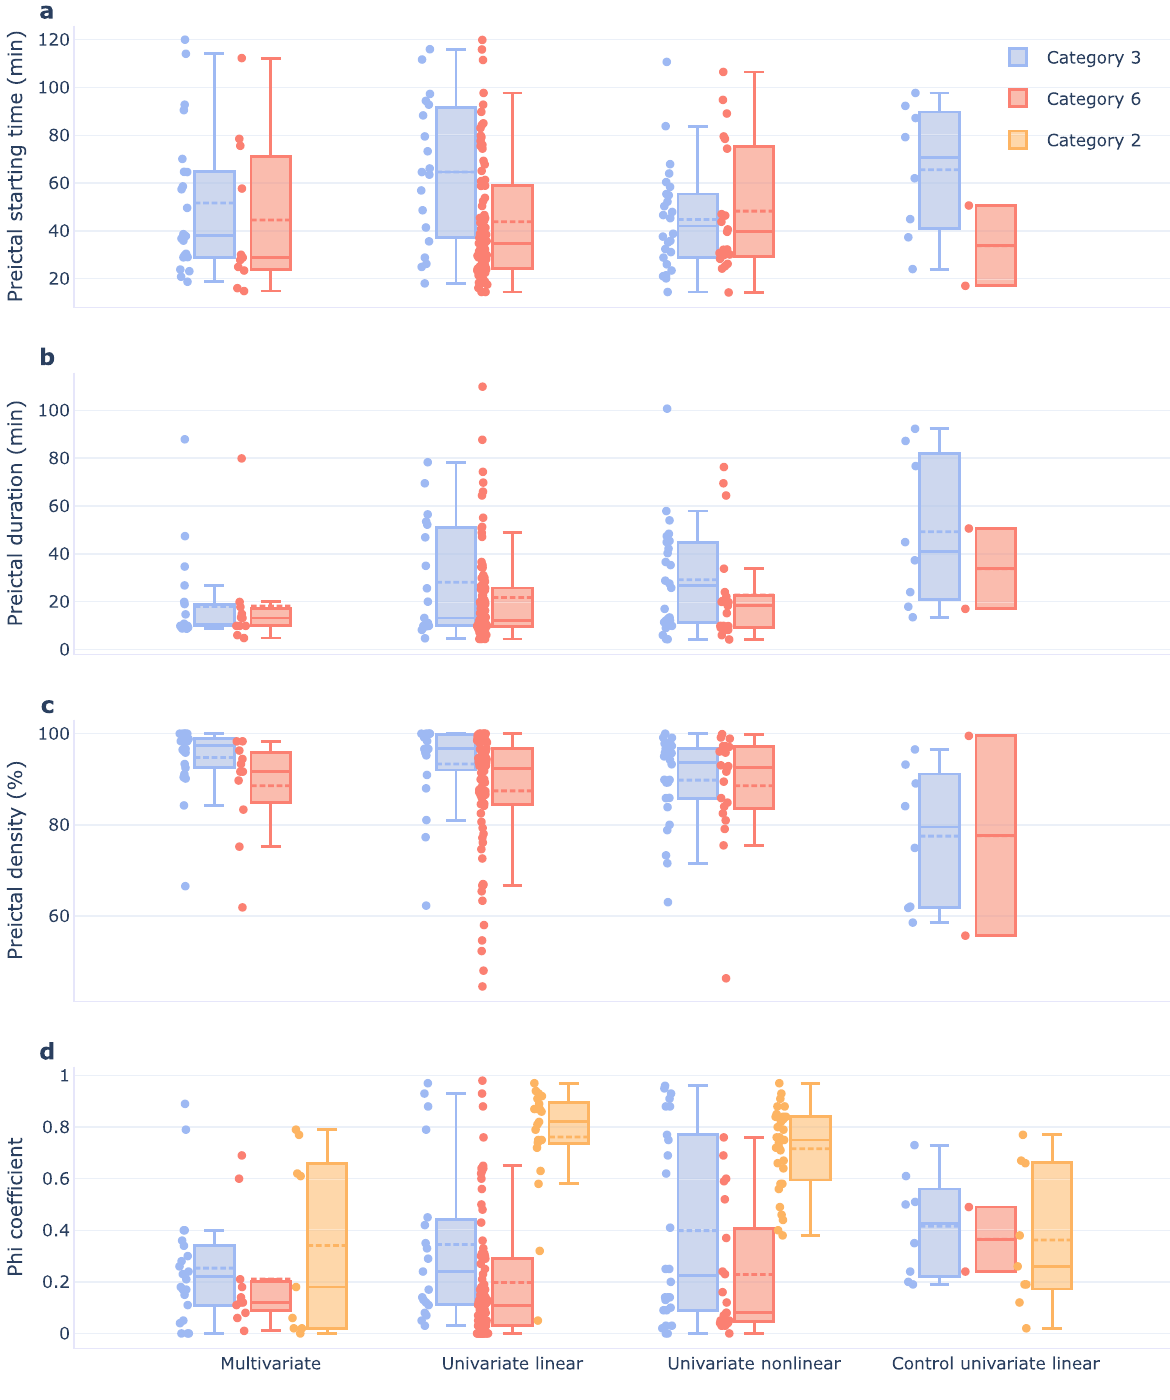
Figure 7. Results for preictal interval characterisation. Preictal interval was characterised for categories 3 and 6, for the three groups of features, according to three characteristics: ( a ) starting time before seizure onset, ( b ) duration, and ( c ) density. ( d ) Phi coefficient was computed between preictal clustering solution and the sleep-wake cycle for categories 3, 6, and 2 for the three groups of features. Dots correspond to one of the three preictal characterising variables or to the phi coefficient. Solid and dashed lines indicate medians and means, respectively. Box’s tops and bottoms correspond to the 75th and 25th percentiles, respectively. Whiskers refer to the span of the preictals characteristics or the phi coefficient after discarding